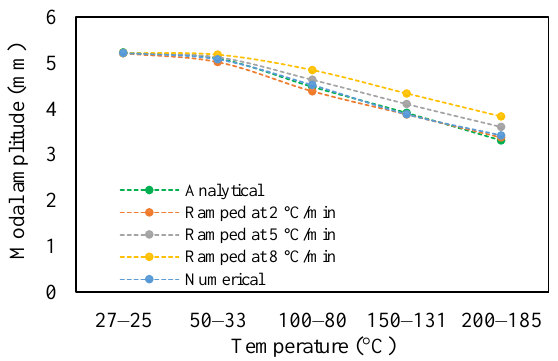
Figure 15. Modal amplitude of healthy specimen in non-uniform temperature.